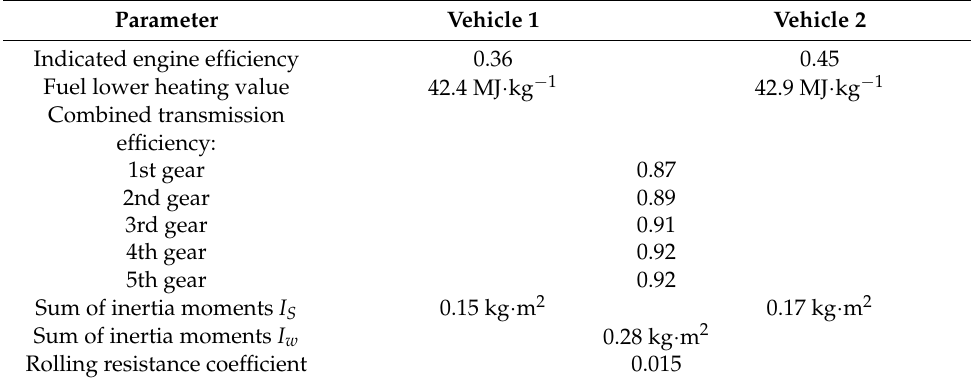
Table 2. Values of constants used for calculation of fuel